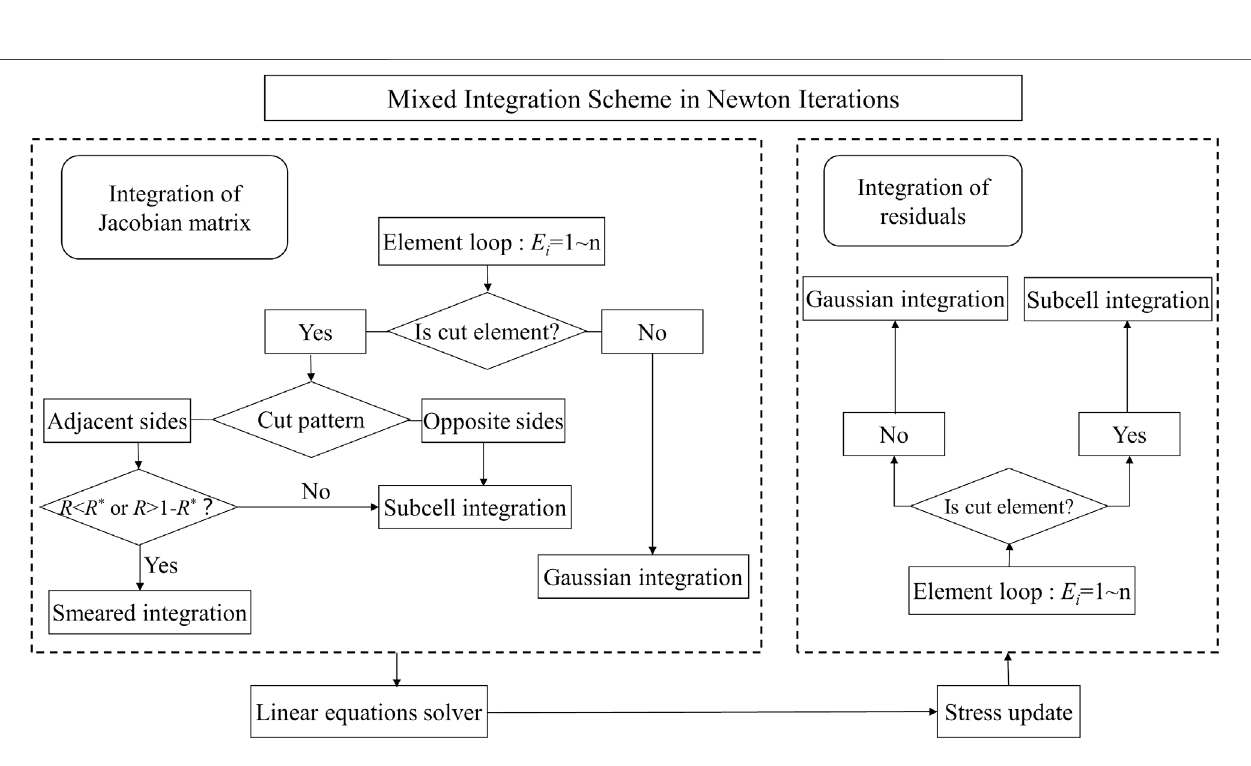
FIGURE 8 | Flow chart of mixed integration